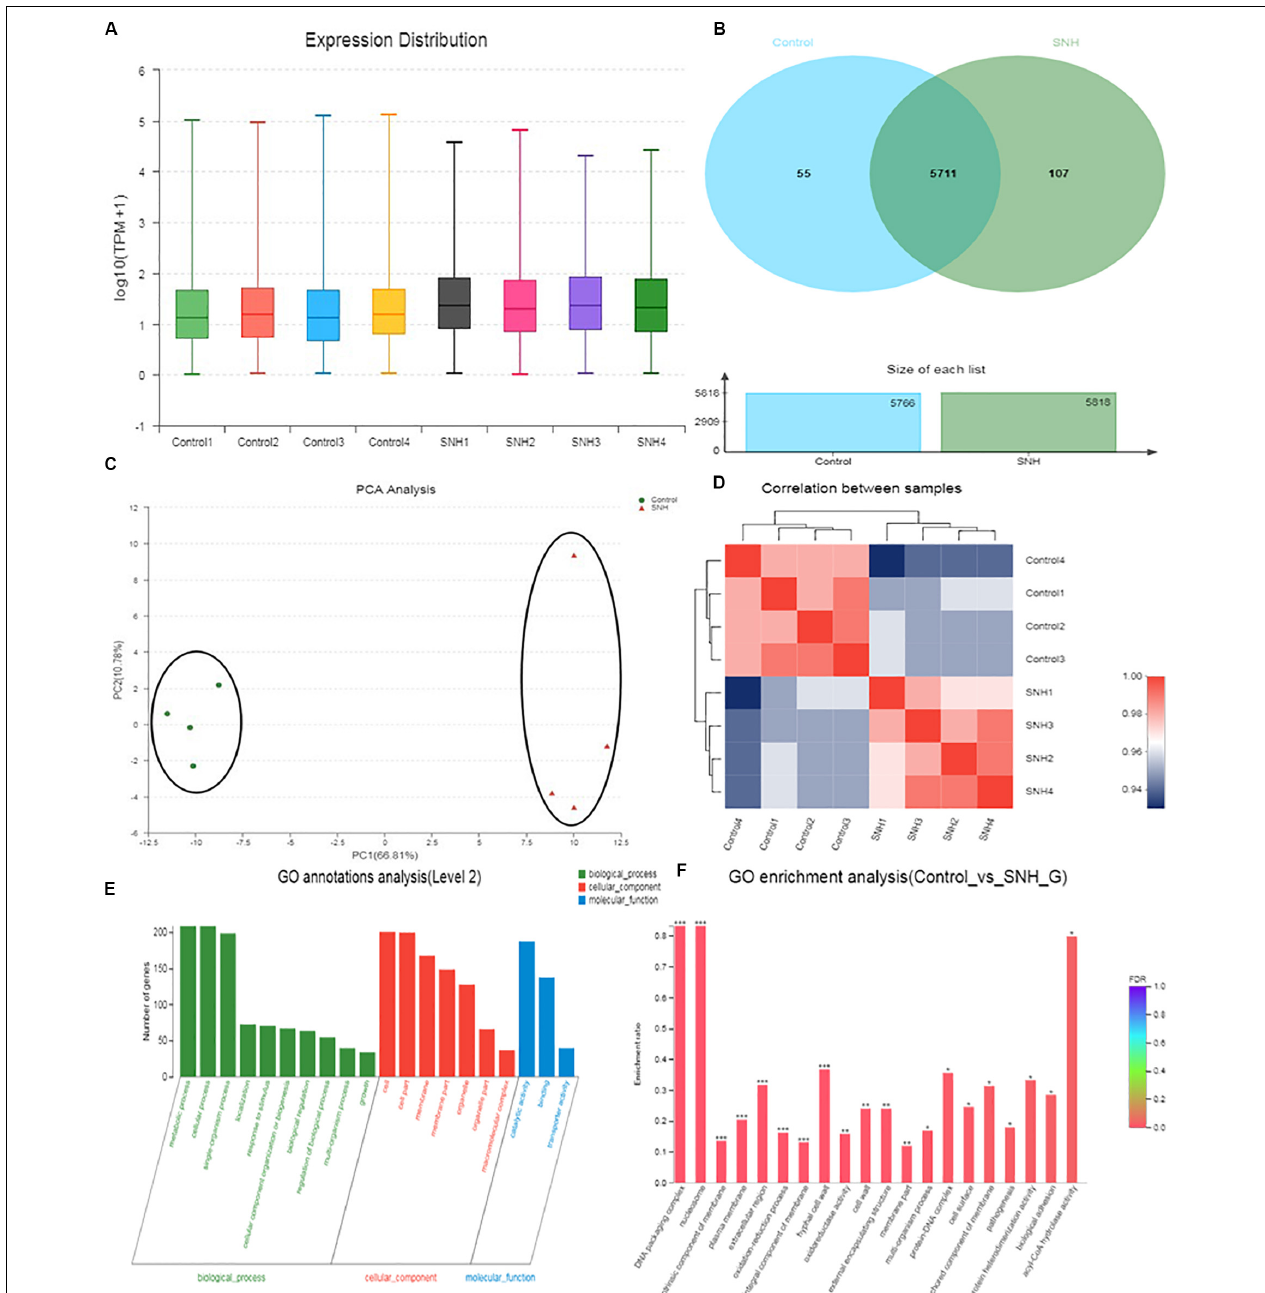
FIGURE 5 | Effect of SNH on the transcriptome of C. albicans SC5314. (A) The abscissa is the sample name and the ordinate is log 10 (TPM + 1). Each color in the figure represents a sample, and the horizontal line in the figure indicates the median of gene expression in the sample. (B) Venn diagram of the number of genes in the Control and SNH treatments, respectively. (C) The right and lower sides of the figure are sample names, and the left and upper sides are sample clustering, and the squares of different colors represent the correlation between the two samples in the principle component analysis (PCA). (D) After the sample is analyzed by dimensionality reduction, there are relative coordinate points on the principal component. The distance between each sample point represents the distance of the sample. The closer the distance is, the higher the similarity between samples. The horizontal axis represents the contribution of principal component 1 (PC1) to the differentiated samples in the two-dimensional map, and the vertical axis represents the contribution of principal component 2 (PC2) to the differentiated samples in the two-dimensional map. (E) The abscissa in the figure represents the secondary classification term of GO, the left ordinate indicates the percentage of genes or transcripts contained in the secondary classification, and the right ordinate indicates the genetic/transcription of the secondary classification. (F) The abscissa indicates the GO term, and the ordinate indicates the enrichment rate refers to the ratio of the number of genes/samples enriched in the GO term to the number of the annotation gene/background number. The color indicates the significance of the enrichment, and the redder the default color indicates that the GO term is significantly more enriched, with the FDR < 0.001 mark being ***, the FDR < 0.01 mark being **, and the FDR < 0.05 mark being *.